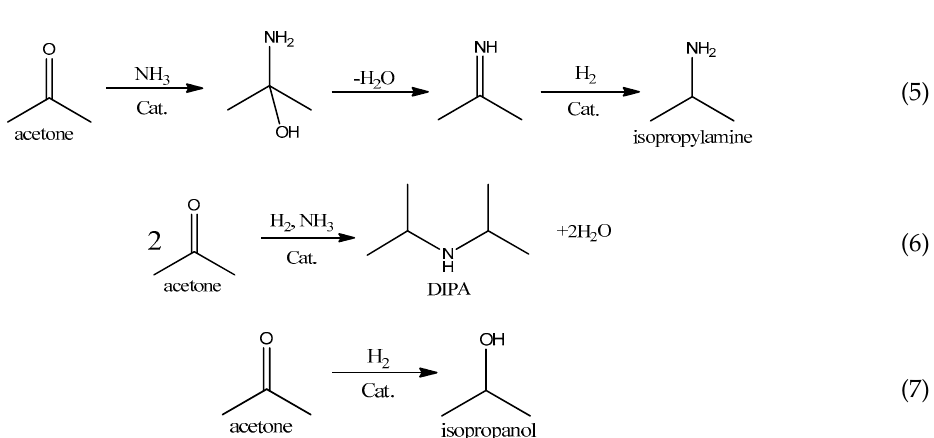
3 , easily adsorbed by Al 2 O 3 acidic sites, was indispensable for the